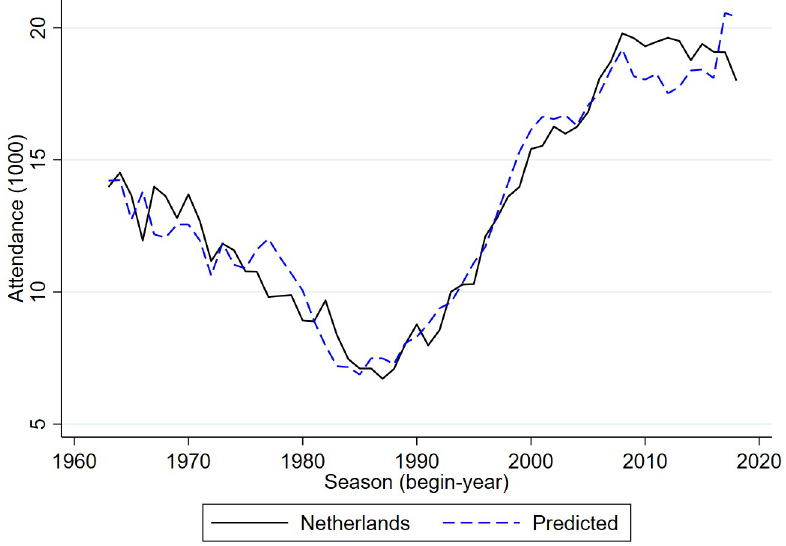
Fig 5. Stadium attendance professional football Netherlands; actual and predicted attendance; 1963/64-2018/19 (1000).